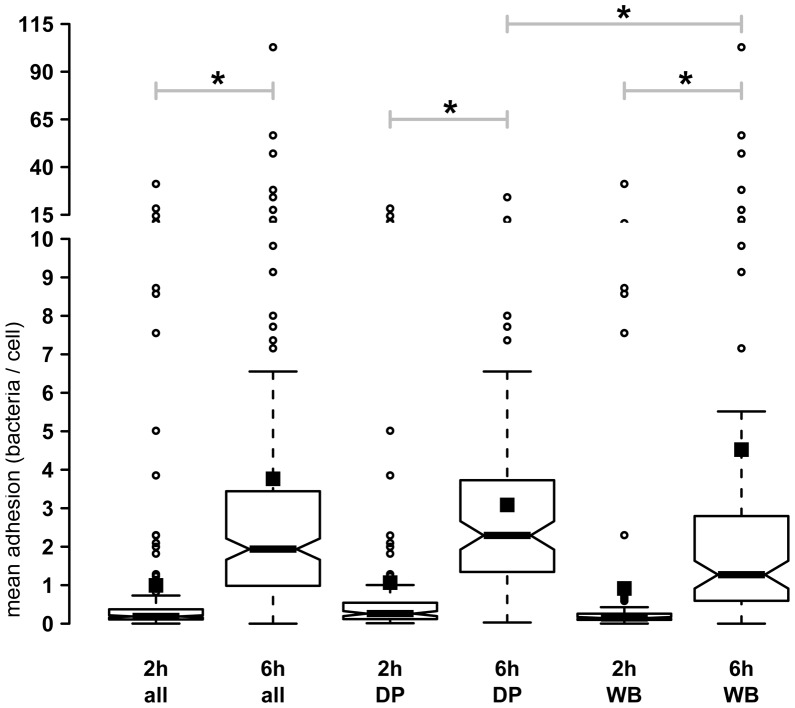
Adhesion rates of E.
coli to IPEC-J2.IPEC-J2 cells were incubated with E. coli from domestic pigs (DP, n = 104) or wild boars (WB, n = 93) over 2 h or 6 h. Adhesion was quantified after removing non-adherent bacteria by washing. There were significant differences in adhesion following 2 h and 6 h incubation periods. Additionally, there was a significant difference in adhesion between E. coli from domestic pigs and wild boar after 6 h incubation. All: isolates of domestic pigs and wild boars together, *: p<0.05 between the groups connected by the beam. Solid squares represent the sample mean.